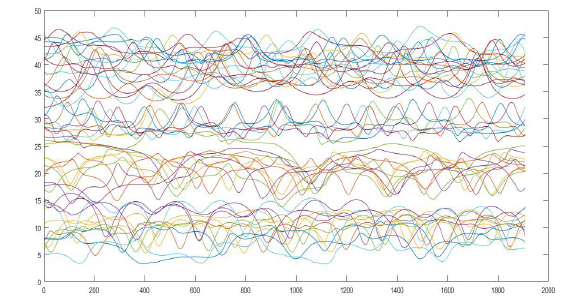
Fig. 12. Geometry A50, the position of the Y-coordinates of the cells’ centre at each step of the simulation.